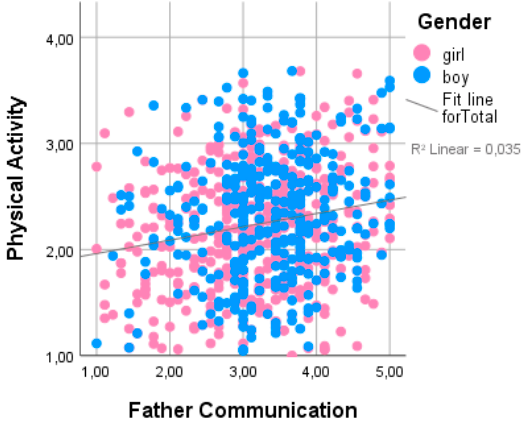
Figure 2. Interrelationships among PA, adolescent gender, and father communication subscale. Table 2. Correlations between physical activity and other study variables.